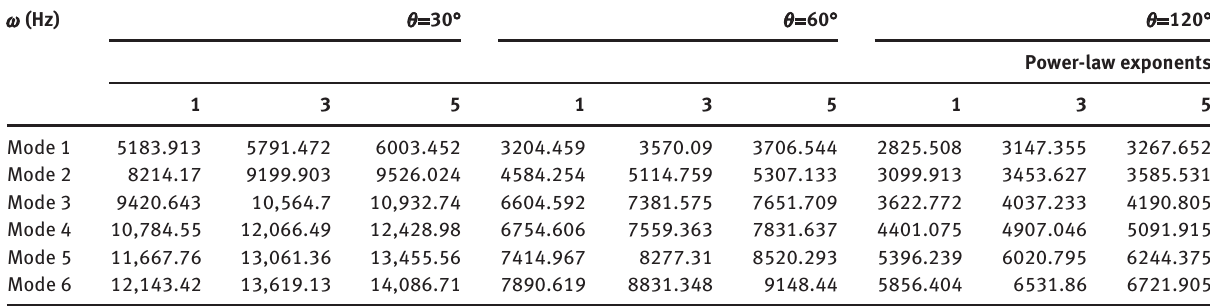
Table 2 Natural frequencies of a fully clamped isotropic FG annular sector plate for different power-law exponents and sector